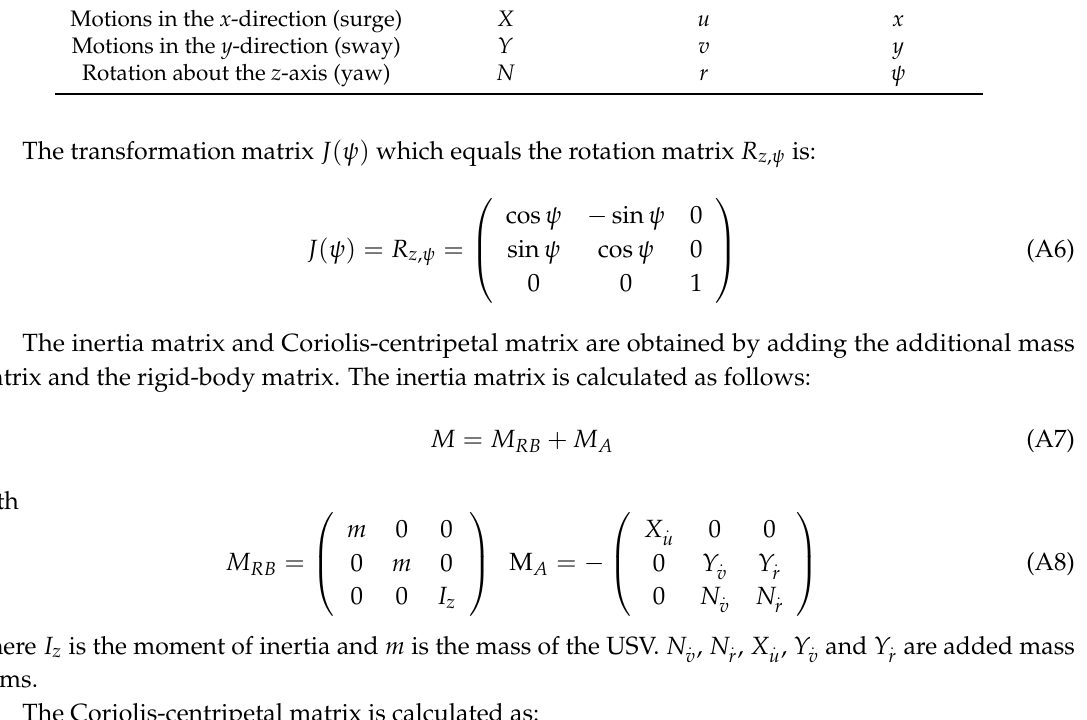
Table A1. The notation of SNAME (1950) for marine vessels. Forces Linear and Positions and and Moments Angular Velocities Euler Angles Motions in the x -direction (surge) X u x Motions in the y -direction (sway) Y v y